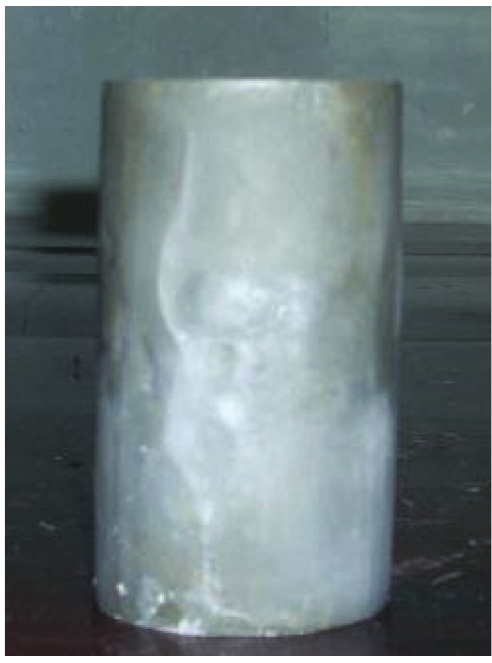
Figure 2: Specimen sealed up with